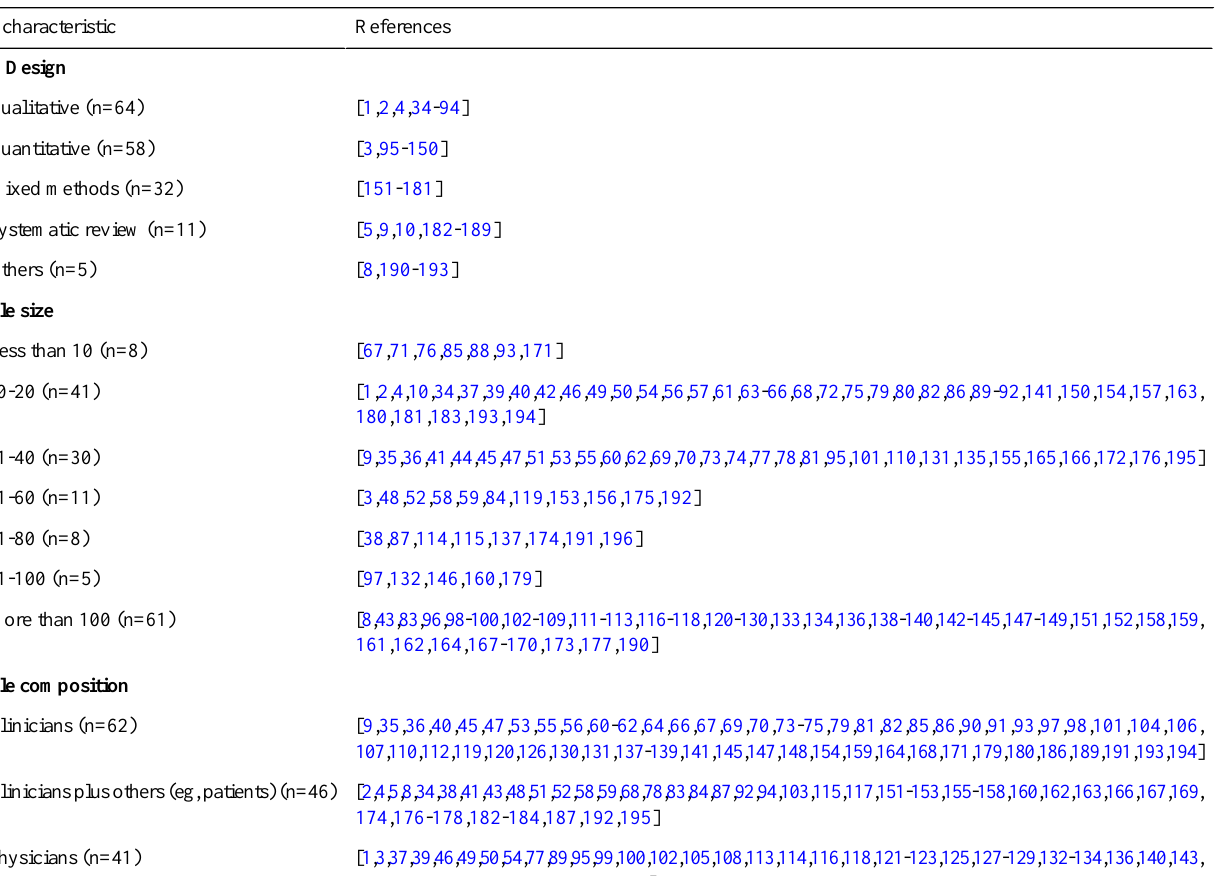
Table 1. Characteristics of included